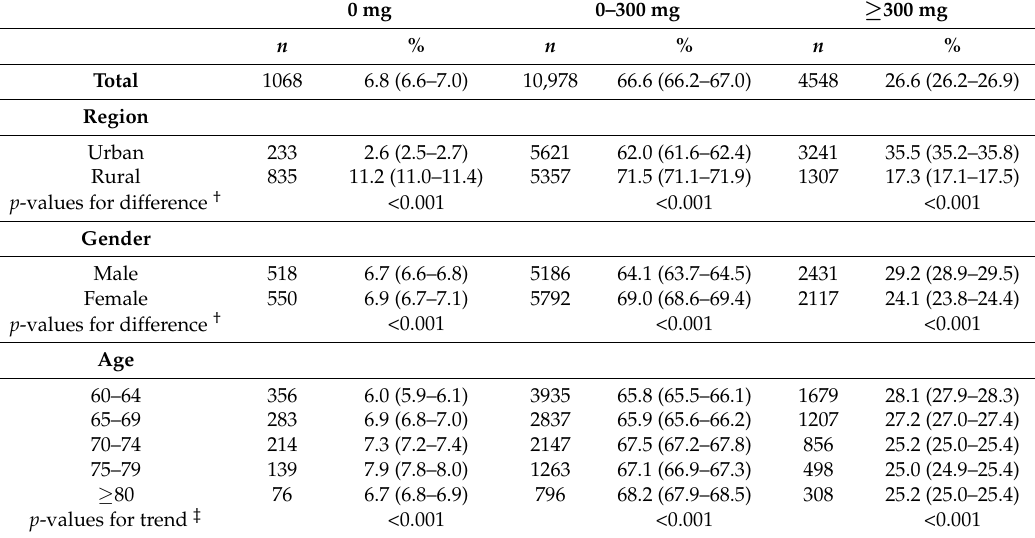
Table 3. Distribution of dietary cholesterol intake levels by age, sex and